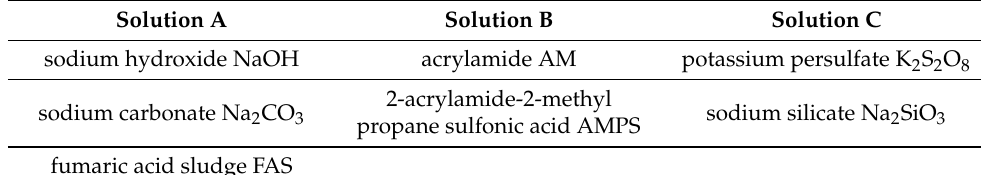
Table 2. Composition of